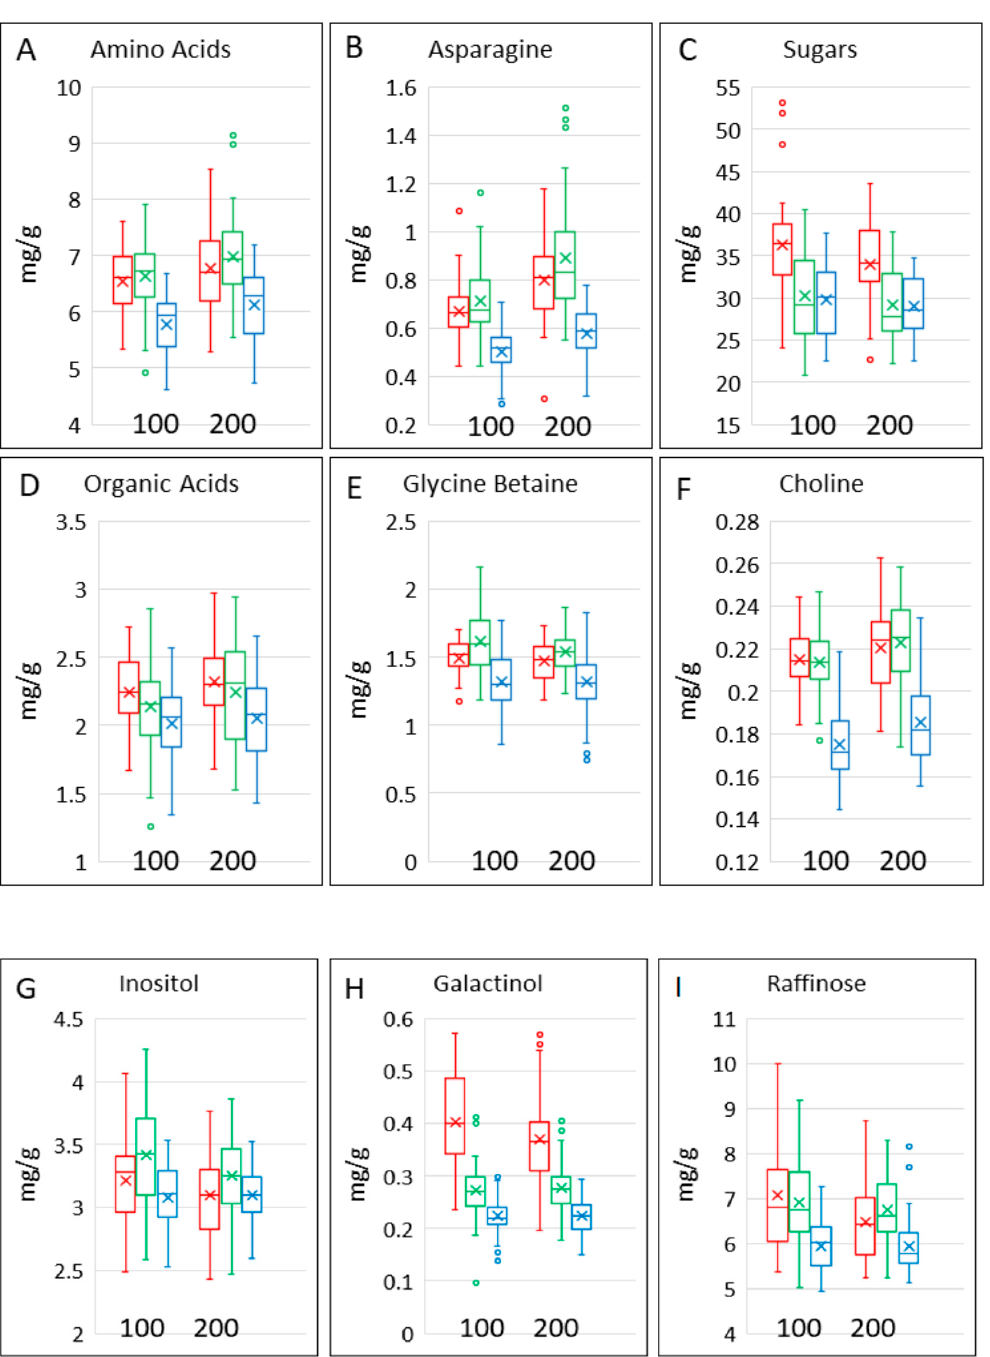
Figure 3. Contents of selected polar metabolites and groups of metabolites in grains of the three cereal types grown in four environments. Colour code: red, emmer; green, spelt; blue, bread wheat. The bar shows the range of the whole data set. The box shows the middle two quartiles, separated by the horizontal line, which is the median, and the vertical lines are the upper and lower quartiles, respectively. Outliers are shown as circles. The x is the mean average. All analyses are expressed on a dry weight